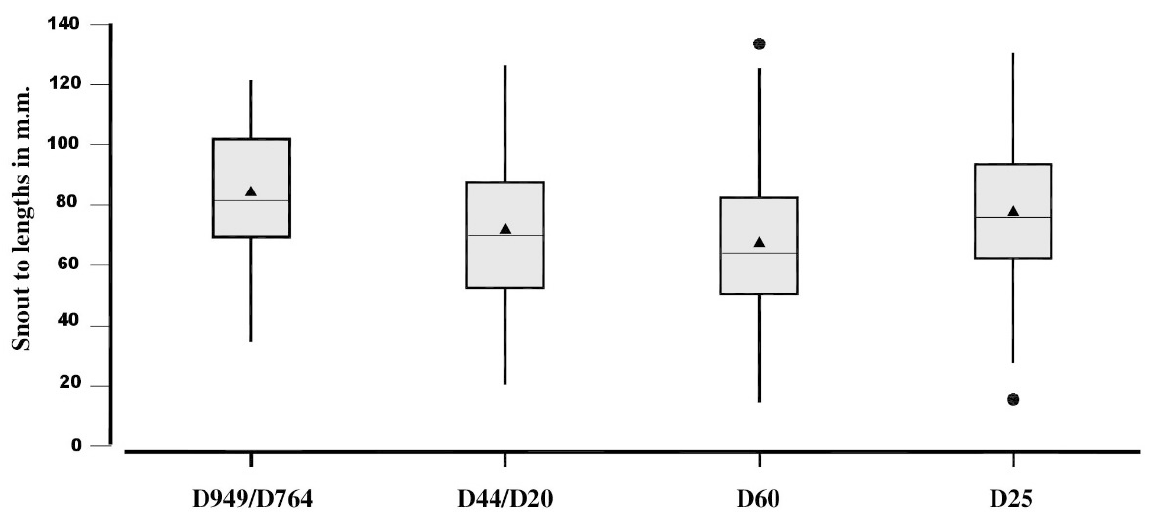
Figure 5. Box plots of SVL distributions of the four populations. Gray boxes indicate central 50%